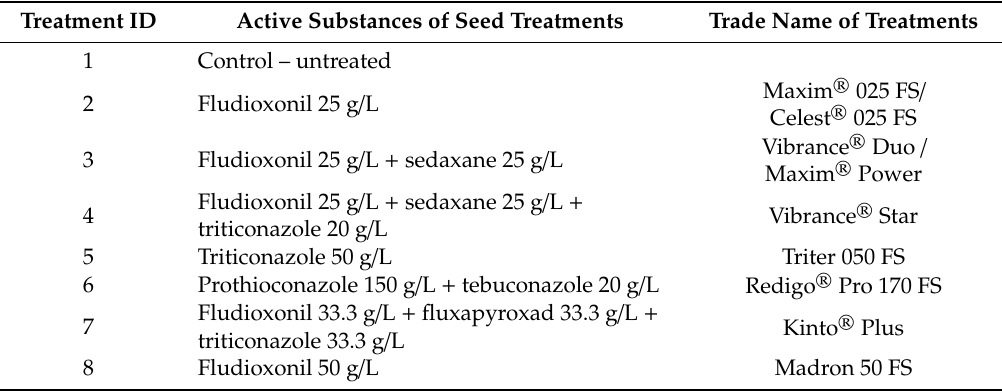
Table 1. Active substances and trade names of seed treatments used in